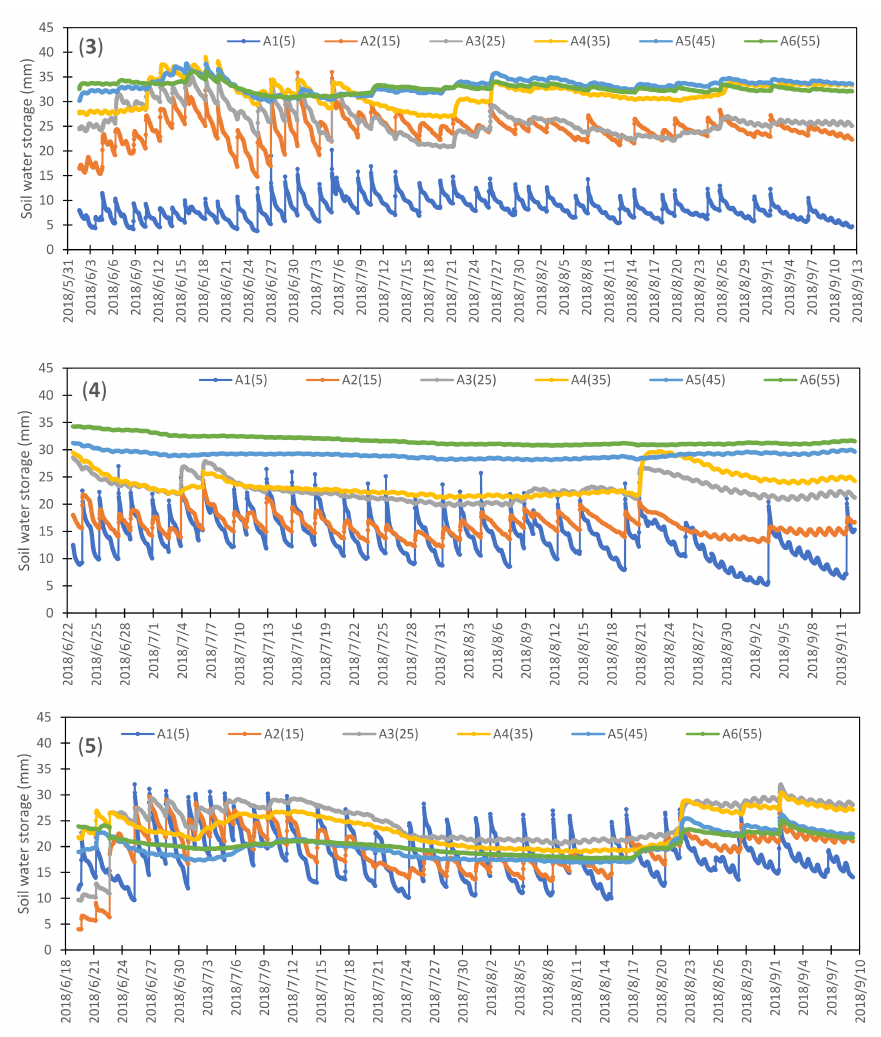
Figure 6. Soil water dynamics in five commercial potato fields during the 2018 growing season at 5 cm (A1), 15 cm (A2). 25 cm (A3), 35 cm (A4), 45 cm (A5), and 55 cm (A6) below the soil surface. ( 1 ) Field 1; ( 2 ) Field 2; ( 3 ) Filed 3; ( 4 ) Field 4; ( 5 ) Field